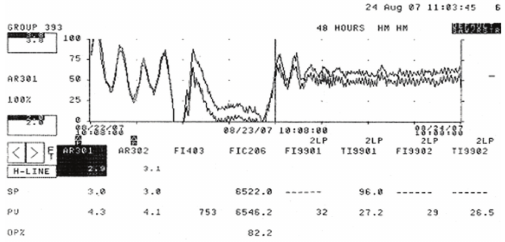
Figure 4: The scene record plan of model-free control